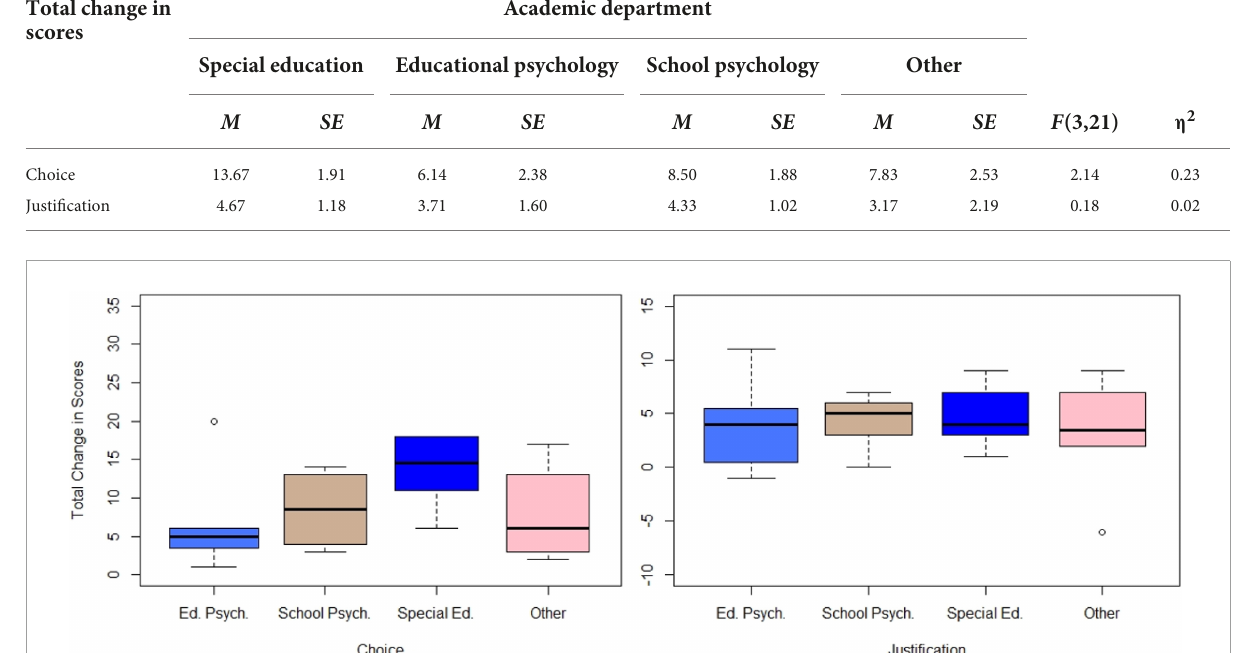
TABLE 4 Analysis of variance results for academic department.